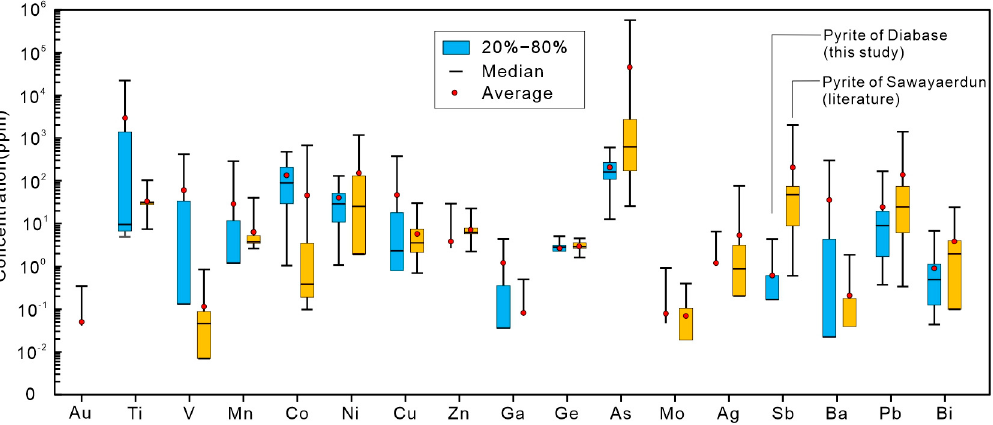
Figure 9. Trace element concentration of pyrite from the Aksu Neoproterozoic diabase dykes and Sawayaerdun gold deposit in Chinese South Tianshan. Data source: Sawayaerdun gold deposit [71].